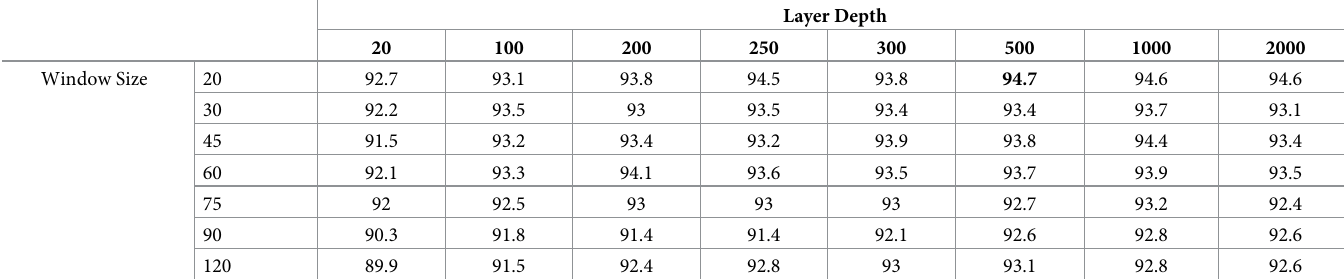
Table 3. 5-fold averages of the test F1 scores of the proposed model for various window sizes and layer depths. The highest score is